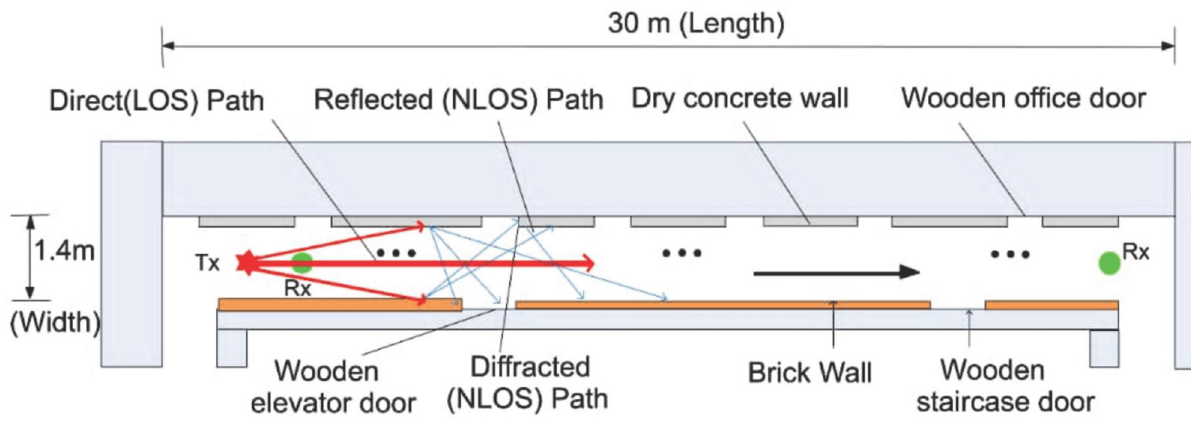
Fig 7. Measurement environment floor plan.